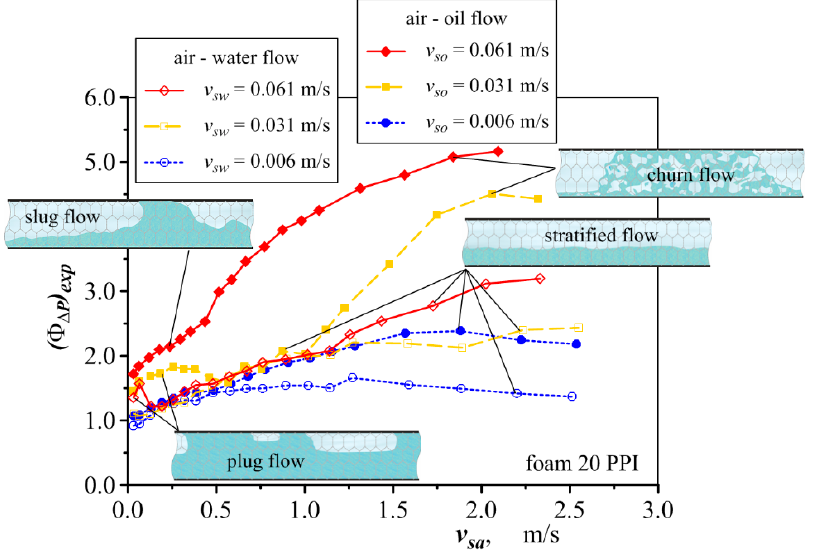
Figure 15. Changes in the pressure drop amplification factor (values obtained from measured pressure drops).